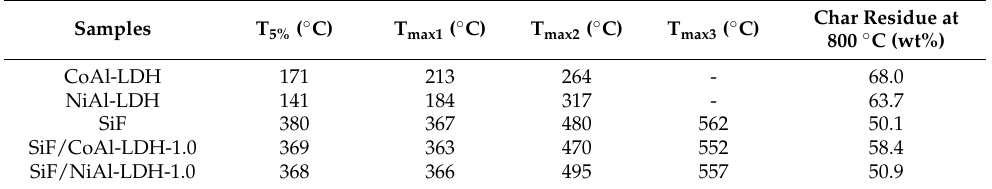
Figure 8. TGA curves for the ( a , b ) CoAl-LDH, NiAl-LDH, and ( c , d ) SiF/LDH nanocomposites in an air atmosphere. Table 4. TGA data of the CoAl-LDH, NiAl-LDH, and SiF/LDH nanocomposites in an air atmos- phere.